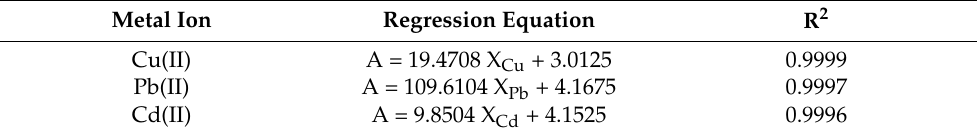
Table 3. Regression equation for the calibration curve (concentration range of 1–5000 µ g L − 1 ).